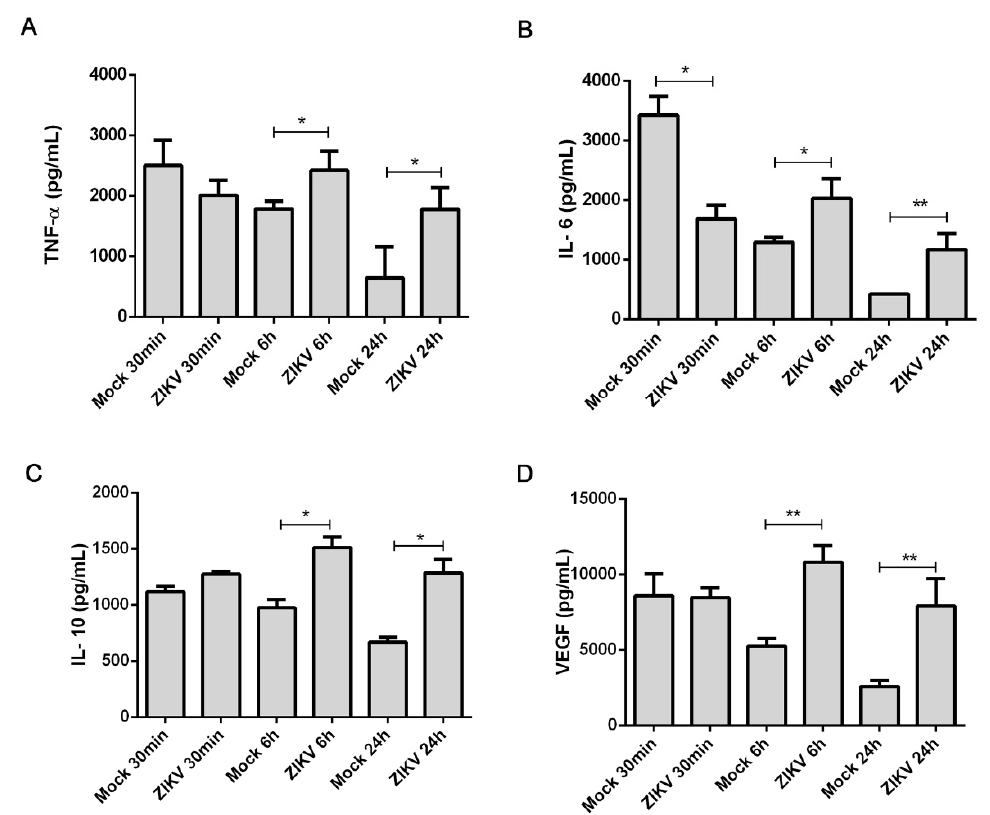
Figure 4. Cytokine and VEGF release by HMC-1 cells in response to ZIKV interactions. The supernatants of HCM-1 cells were collected after incubation with ZIKV or mock viral stocks for 30 min or following a 1 h incubation with an additional 6 or 24 h incubation. Commercial ELISAs were used to measure the level of released ( A ) TNF- α , ( B ) IL-6, ( C ) IL-10 levels and ( D ) VEGF. Data represent the mean of triplicate values for each sample obtained from three independet experiments. * Statistically significant differences assessed by a Mann–Whitney test ( p < 0.05).